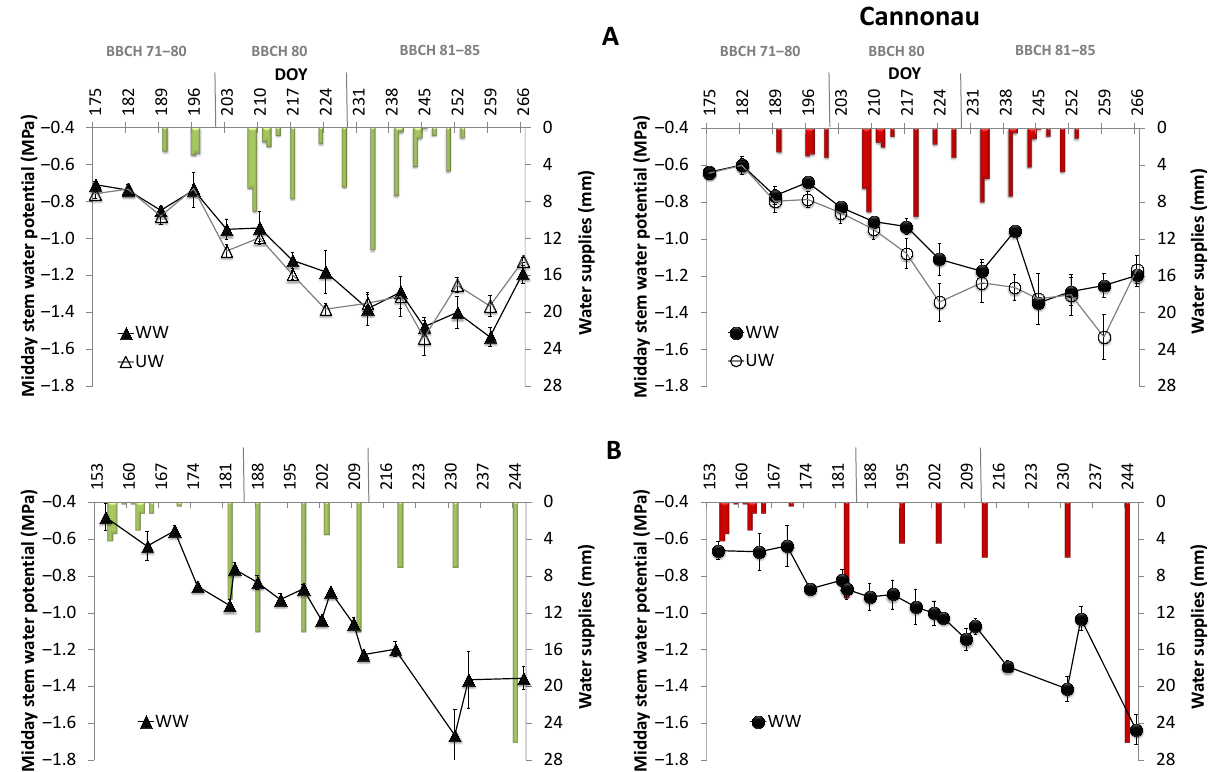
Figure 1. Weekly pattern of midday stem water potential (mean values ± standard error and daily water supplies from precipitation and irrigation, from BBCH stage 75 until 89, in the re-watered (WW) and un-watered (UW) Vermentino and Cannonau vineyards of the Romangia site, during 2019 ( A ); and in the re-watered vineyards (WW) of the Gallura site in 2020 ( B ). The histograms represent water supplies and the lines represent mΨs.